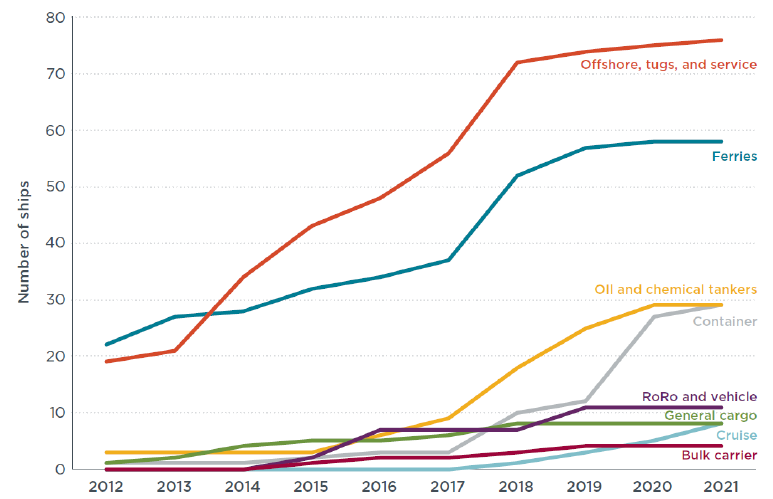
Figure 14. Number of ships build or ordered by mid-2018. Reprinted from ref. [58].